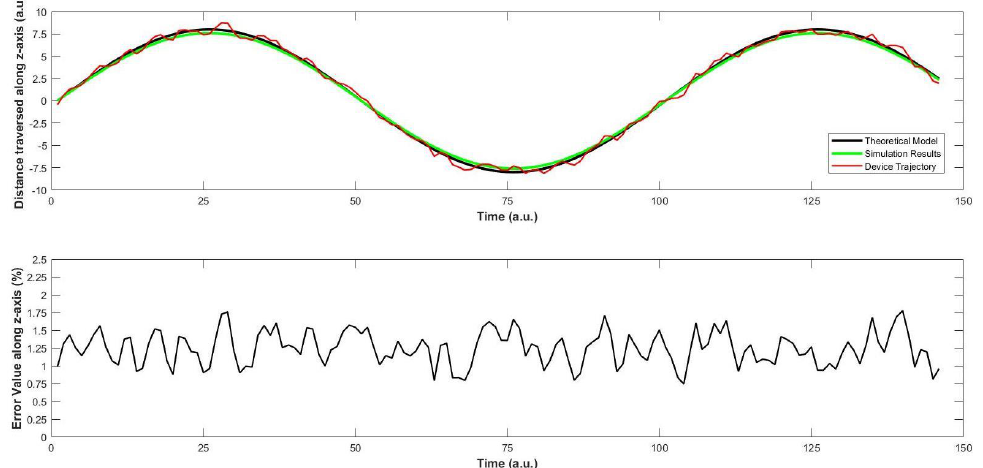
Figure 13. Second trajectory scenario: Investigation of change in values of z. ( top ) shows a comparison between the ideal, simulation and actual (trajectory) values during the movement of the quad-copter along the z-axis, and ( bottom ) shows the average error between the simulated results and the actual (trajectory) values, which is very